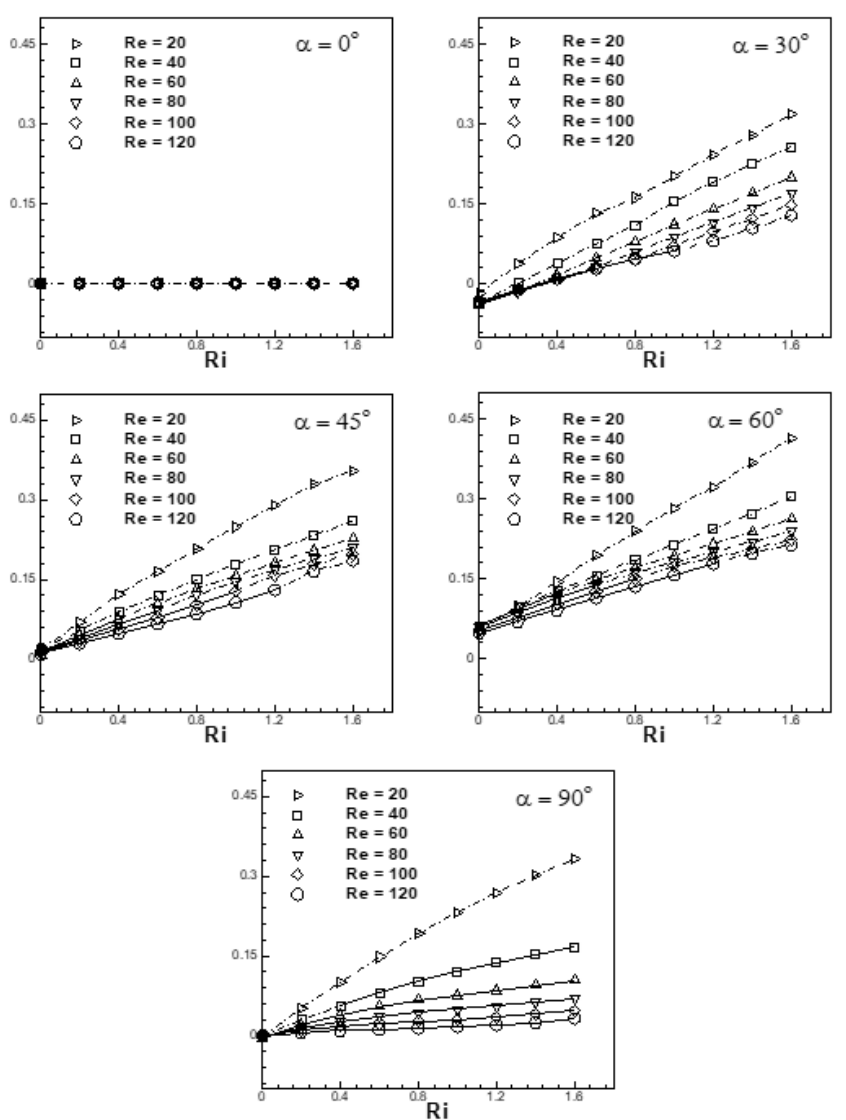
Figure 31. Variation of time mean Nusselt number ( R i 0 . 0 Figure 25. Variation of the mean/steady coefficient of moment with Richardson number at Figure 25. Variation of the mean/steady coe fficient of moment with Richardson number at 20 ≤ Re 20 ≤ Re ≤ 120, 0 ◦ ≤ α ≤ 90 ◦ and 0 ≤ Ri ≤ 1.6 (— — — — steady flow, number for 20 ≤ Re ≤ 120, 0 ° ≤ α ≤ 90° and 0 ≤ Ri ≤ 1.6 (— — — — steady flow, unsteady ≤ 120, 0 ° ≤ α ≤ 90 ° and 0 ≤ Ri ≤ 1.6 (— — — — steady flow, unsteady flow). flow). flow).